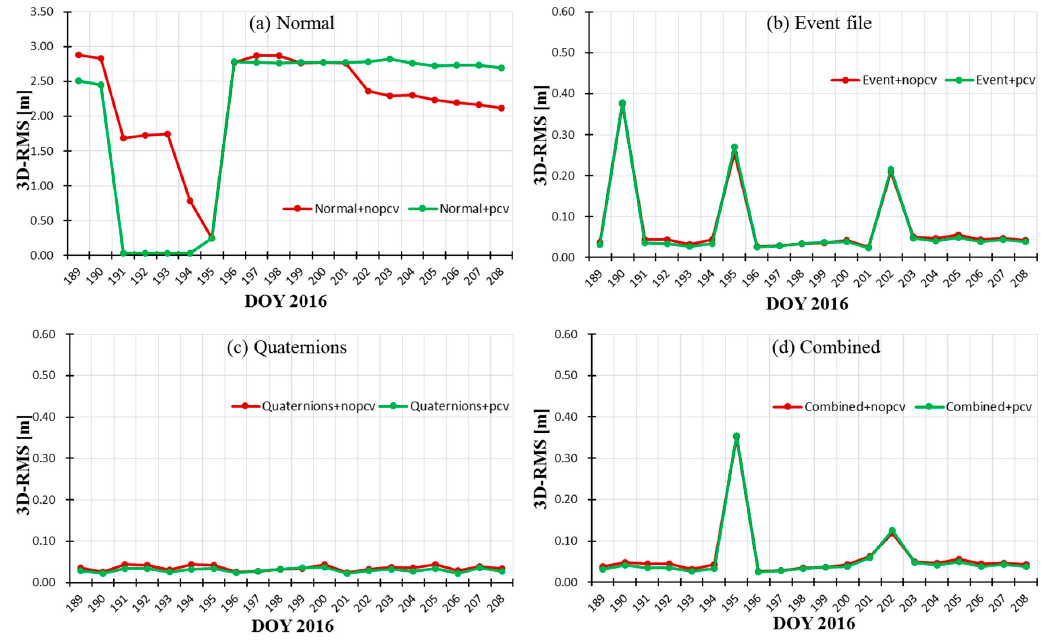
Figure 12. Accuracy comparison of the eight schemes according to different attitude modes.